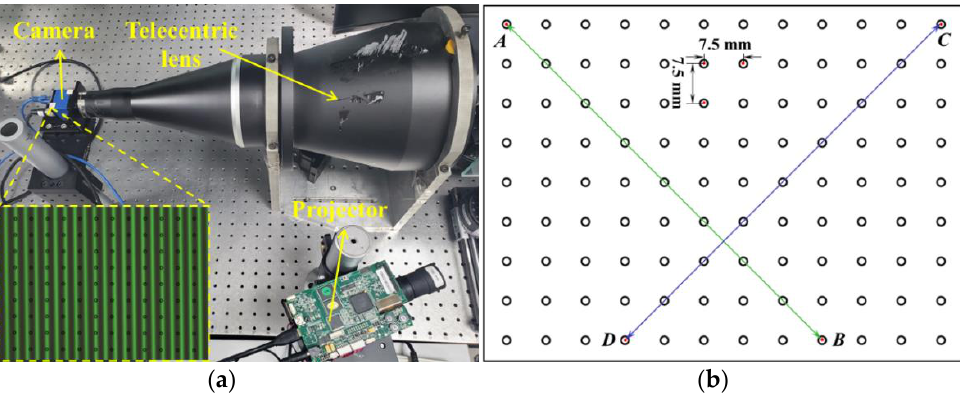
Figure 3. ( a ) Photograph of the experimental system and ( b ) illustration of the measured distances on the calibration